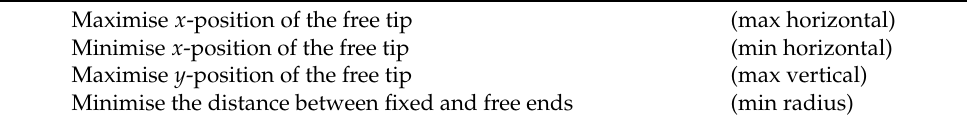
Table 6. Target cases investigated by Ellis et al. [24] replicated in this paper. Maximise x -position of the free tip (max horizontal) Minimise x -position of the free tip (min horizontal) Maximise y -position of the free tip (max vertical) Minimise the distance between fixed and free ends (min